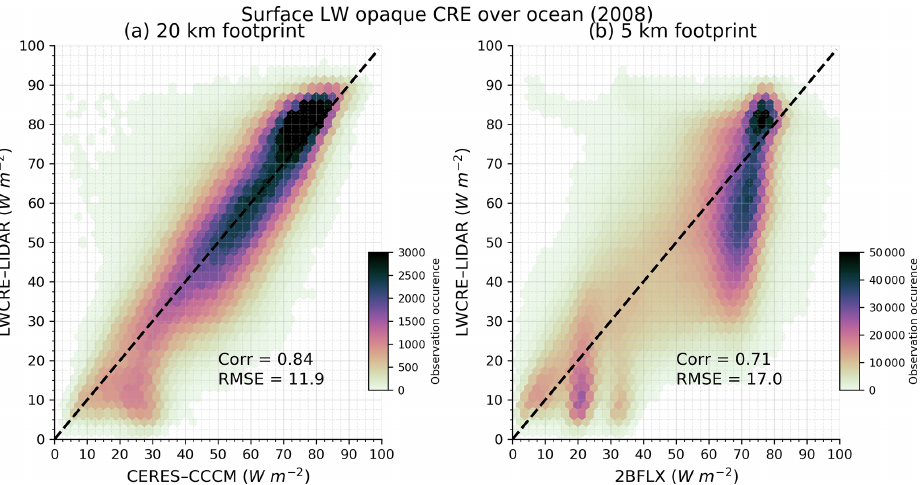
Figure 13. Instantaneous collocated surface LW opaque CRE at footprint scale: (a) LWCRE–LIDAR as a function of CERES–CCCM; (b) LWCRE–LIDAR as a function of 2BFLX. We only consider CERES (CloudSat) footprints where all CALIPSO footprints falling within the CERES (CloudSat) footprints are opaque and which contain at least 40 (10) profiles. Based on collocated observations over the ocean in